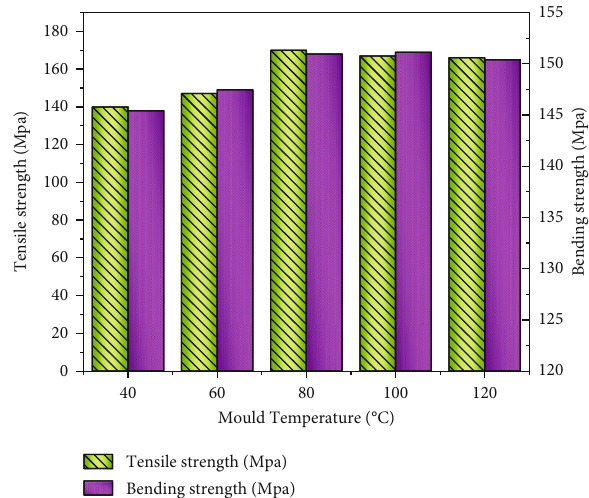
Figure 5: Tensile and bending strength changes with the temperature of the